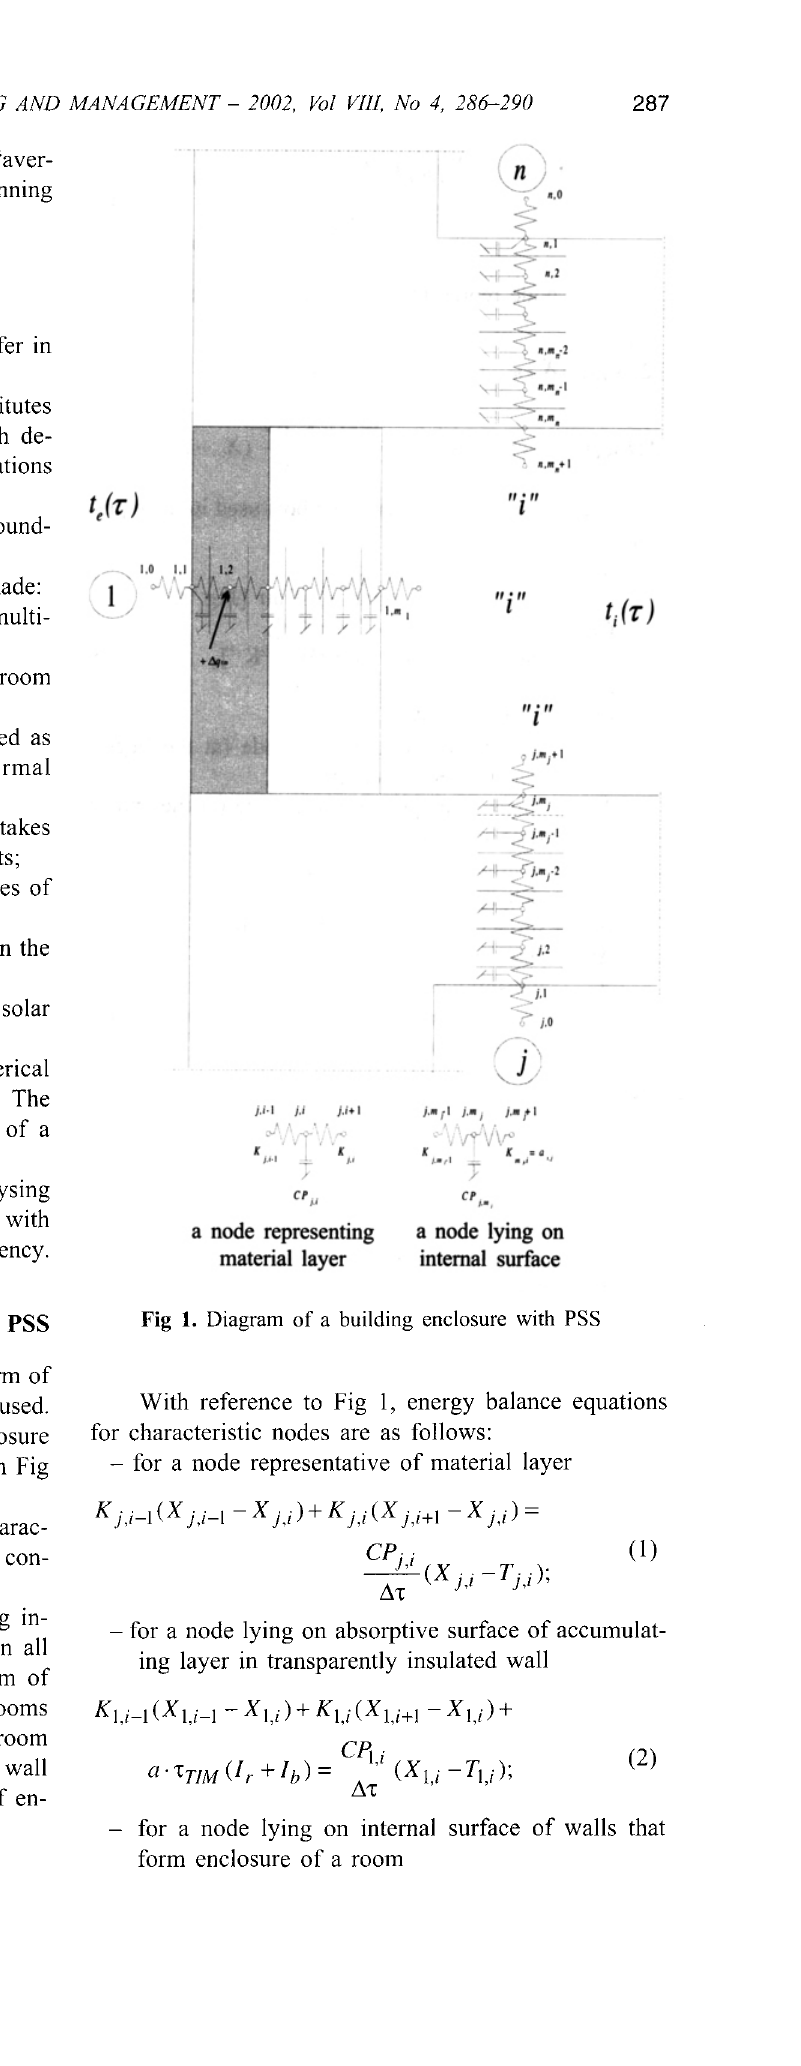
Fig 1. Diagram of a building enclosure with